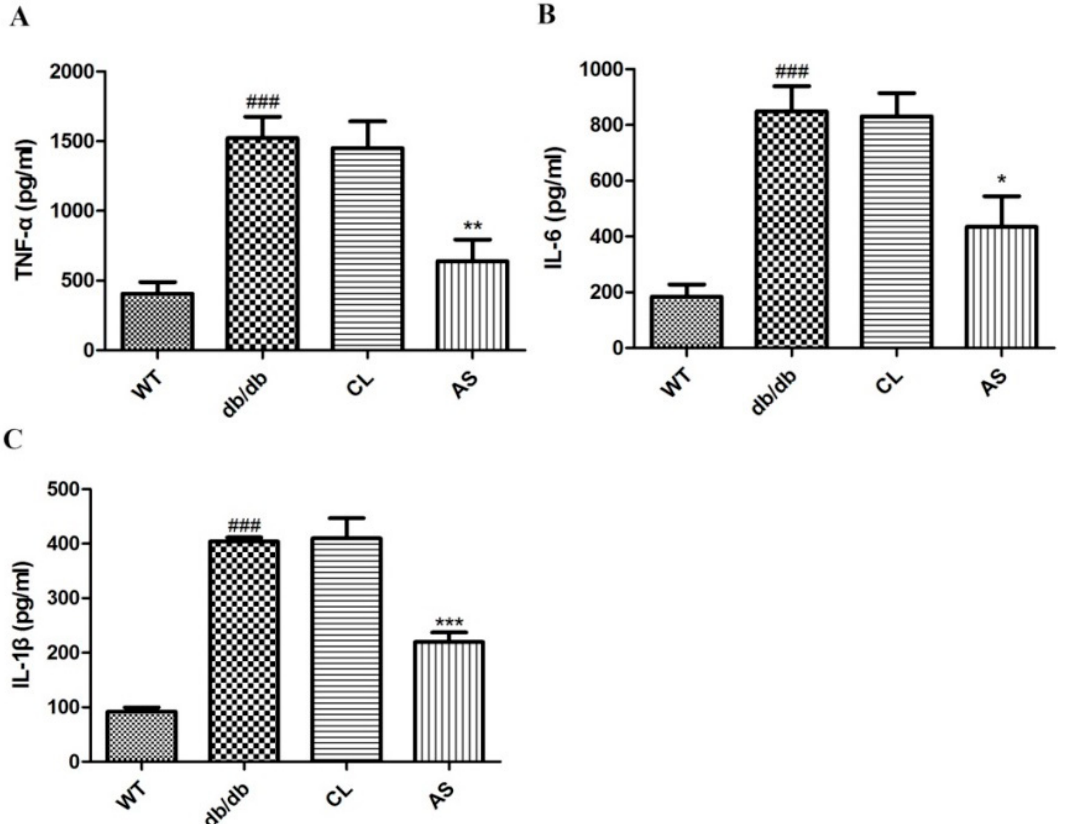
Figure 7. Effect of AS on pro-inflammatory cytokines in db/db mice. Serum ( A ) TNF- α ; ( B ) IL-1 β and ( C ) IL-6 levels were quantified using enzyme-linked immunosorbent assay (ELISA) kits, following the protocol recommended by the manufacturer. Values are expressed as mean ± SEM of 5~6 mice. * p < 0.05, ** p < 0.01, *** p < 0.001 vs. db/db group; ### p < 0.001 vs. the WT group.